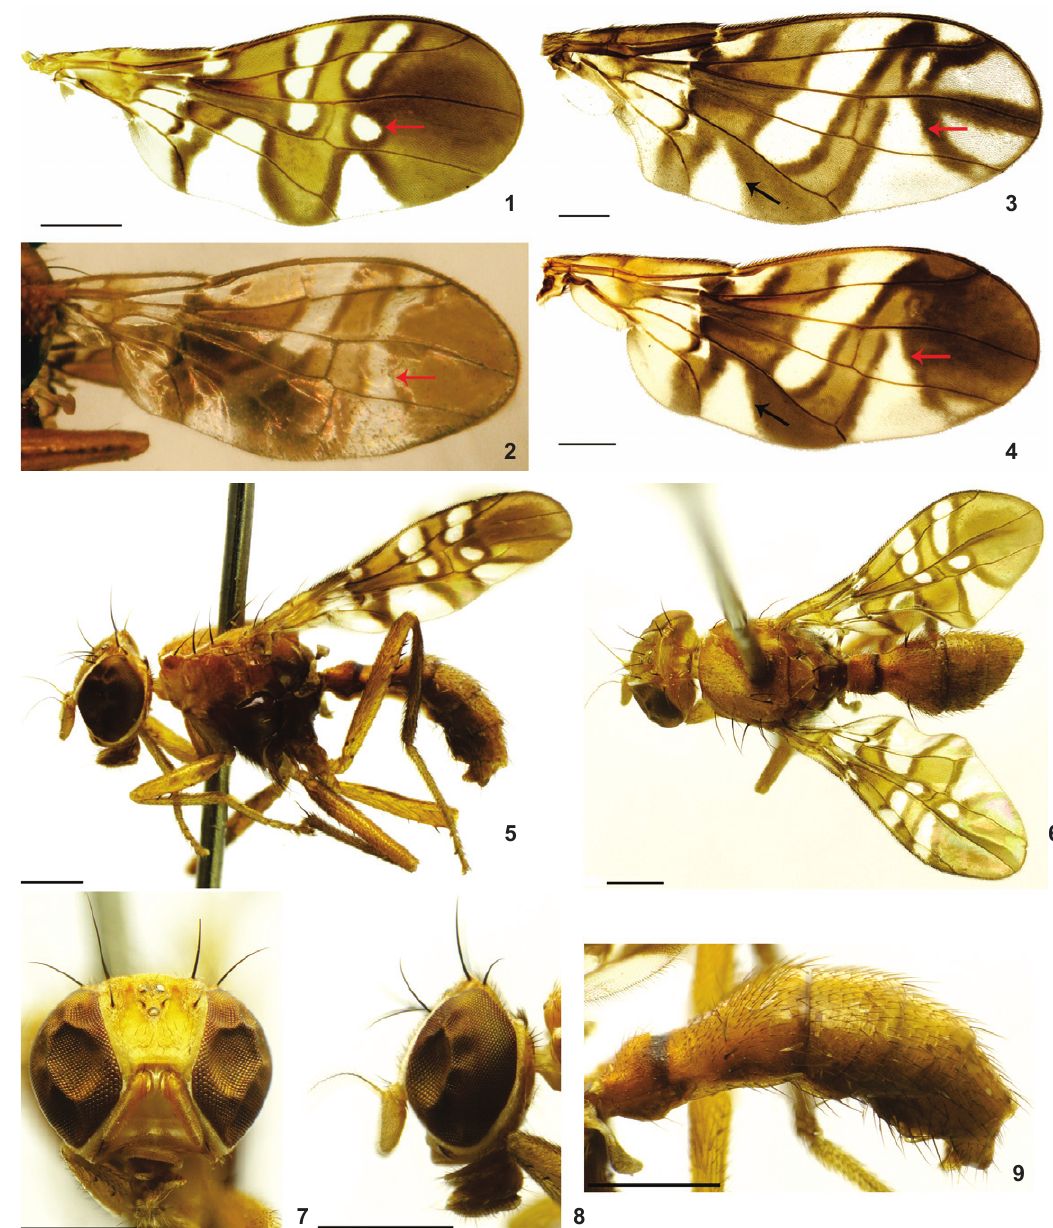
Figures 1-9. (1-4) Wings: (1) Hemixantha maculosa sp. nov. , paratype male; (2) Hemixantha picta holotype female; (3-4) Hemixantha pulchripennis : (3) male; (4) female. Red arrows indicate hyaline areas on cell r middle of cell cua1. (5-9) Hemixantha maculosa sp. nov. , holotype male: (5) habitus, lateral; (6) habitus, dorsal; (7) head, frontal; (8) head, lateral; (9) abdomen, lateral. Scale bars: 0.5 mm. 1+2 twice as wide at apex as at base; twice as long as tergite 3. Tergites 3-5 gradually narrower than apex of syntergite 1+2. Sternite 1 absent. Sternites 2-7 yellow; sternite 2 divided into two parts: anterior very reduced and slightly sclerotized, and ZOOLOGIA 31 (1): 88–96, February, 2014